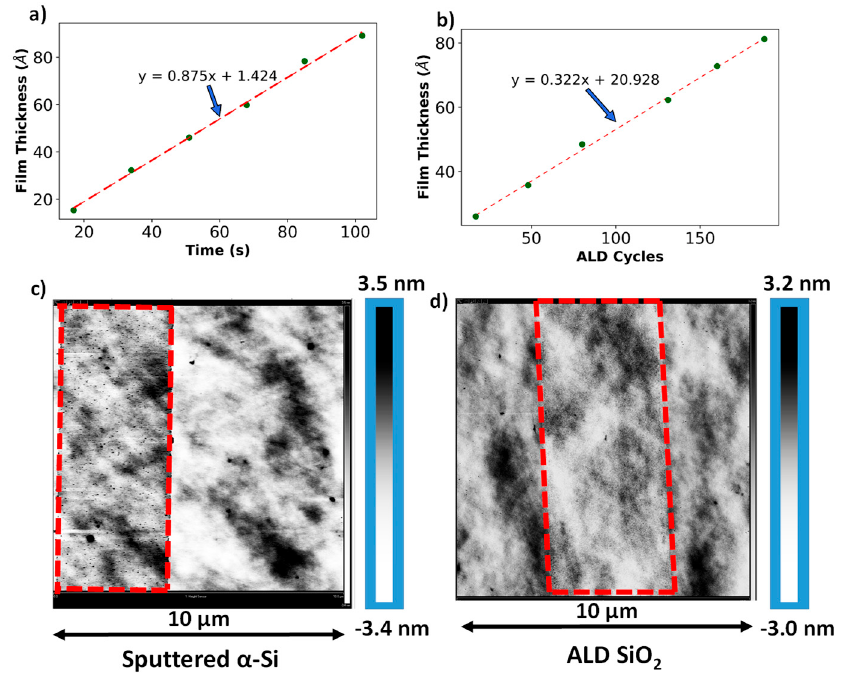
Figure 4. Thickness calibration curves for ( a ) sputtered α -Si and ( b ) ALD SiO 2 , and ( c ) and ( d ) are modified AFM scans showing surface roughness of α -Si ALD SiO 2 thin films. The red dotted lines outline the features patterned using conventional lithographic techniques.